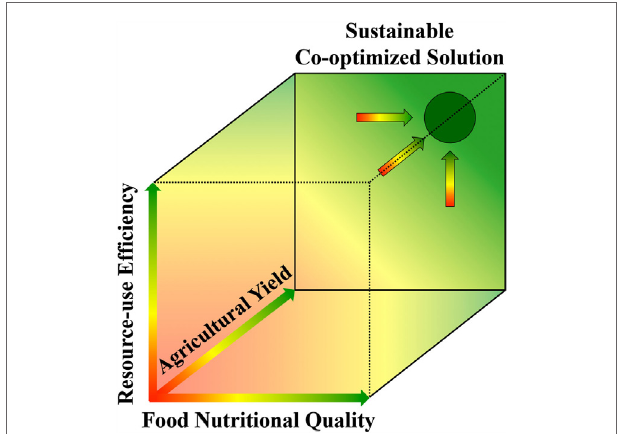
FiguRe 6 | Three-dimensional matrix with three axes representing the three parameters ( x -axis) food nutritional quality (as linked to human health), ( y -axis) crop resource-use efficiency (as linked to environmental health), and ( z -axis) agricultural yield (as linked to social equity through the ability to serve the entire human population) . The purple circle represents high values for all three parameters, thus symbolizing co-optimization of these three parameters via sustainable agricultural